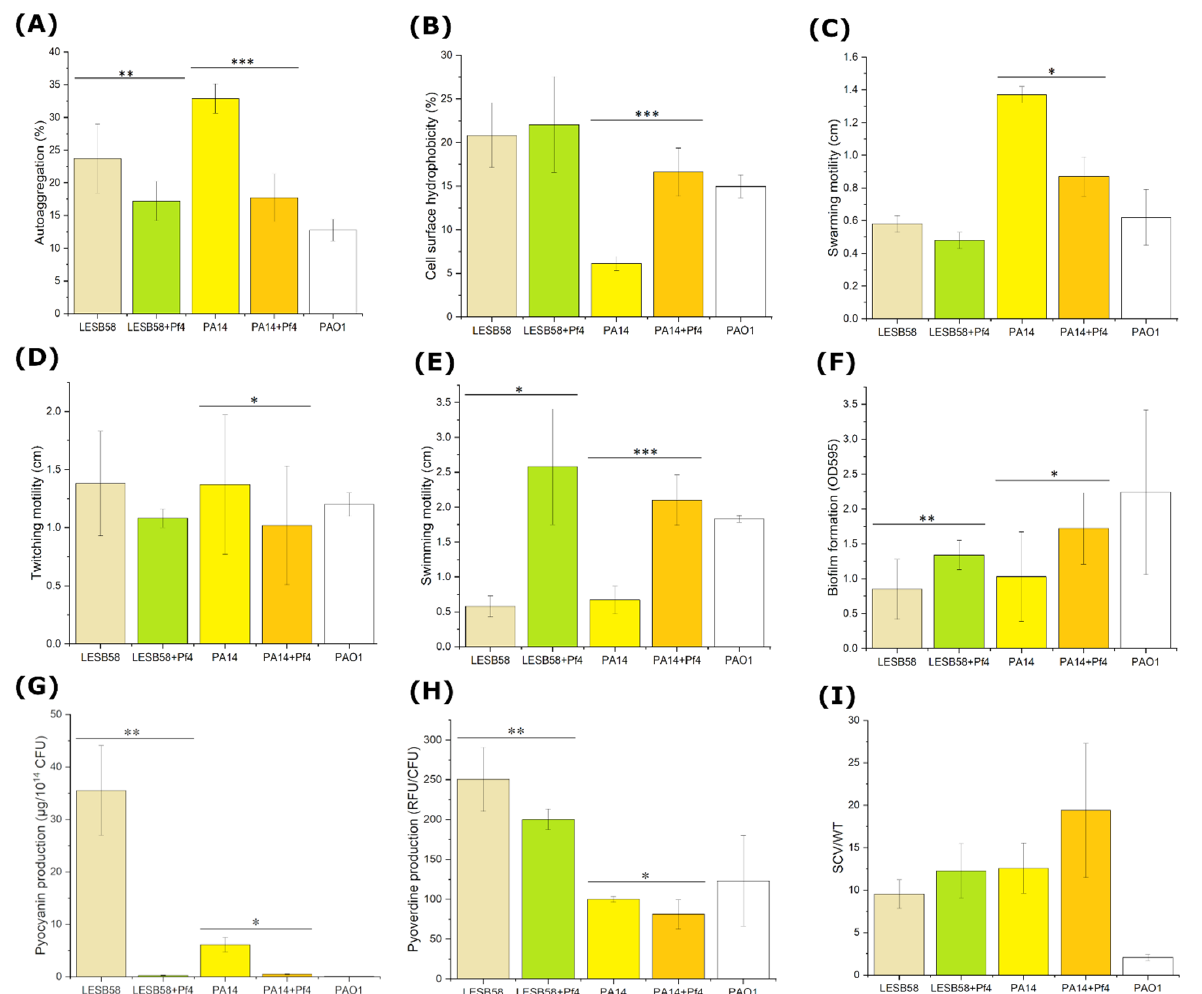
Figure 5. Changes in autoaggregation ( A ), cell surface hydrophobicity ( B ), swarming motility ( C ), twitching motility ( D ), swimming motility ( E ), biofilm production ( F ), pyocyanin ( G ) pyoverdine production ( H ), and prevalence of SCV ( I ) of Pf4 ‐ infected and uninfected LESB58 and PA14 strains. The results are average + S.E. n = 9; *** p < 0.001; ** p <0.01; * p < 0.05; tested by Wilcoxon signed rank test.